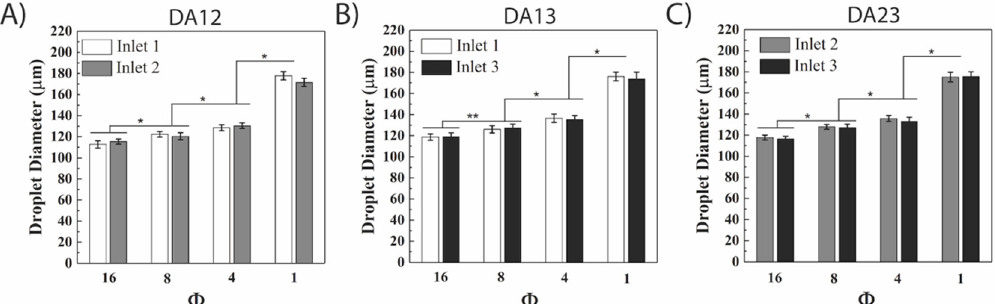
Figure 3. Droplet diameter increased as the oil-to-water ratio ( Φ ) value decreased in double active gravity-driven droplet generation. The relationship between Φ and droplet diameter was elucidated using active inlets 1 and 2 ( A ), inlets 1 and 3 ( B ), inlets 2 and 3 ( C ). The mean droplet diameter from the three different inlets at the same oil-to-water ratio were not significantly different from each other at a given Φ for each experiment. However, the cumulative inlet averages across different Φ values were statistically different with * denoting p > 0.05, ** denoting p > 0.01 thresholds. A minimum of 30 droplets were analyzed for each condition.